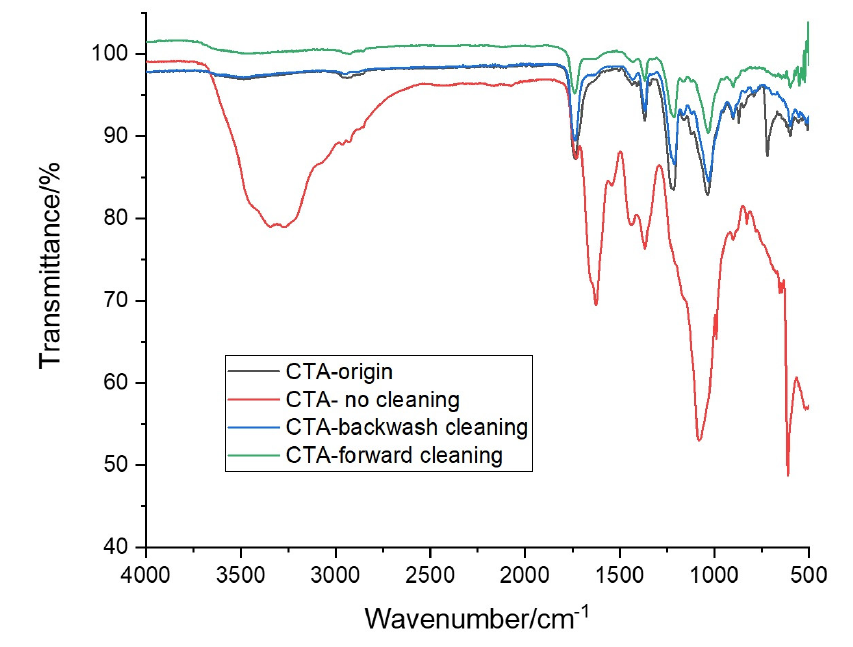
Figure 7. FTIR spectra of the active layer surface of the CTA FO membrane after three consecutive FO runs. Conditions: FS = SWW, DS = MCFDS (300 g / L) and FS and DS flowrate = 1.6 LPM at room temperature for 24 h operating time.